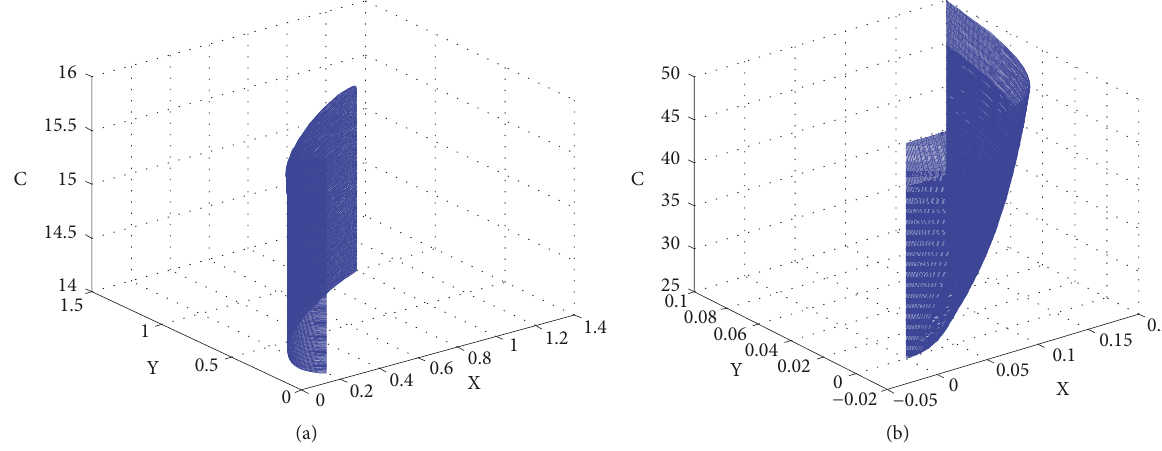
Figure 12: The simulation results with respect to the initial value of (0.2,0.1) and 𝐶 ∈ [14, 50] in Scenario 2.